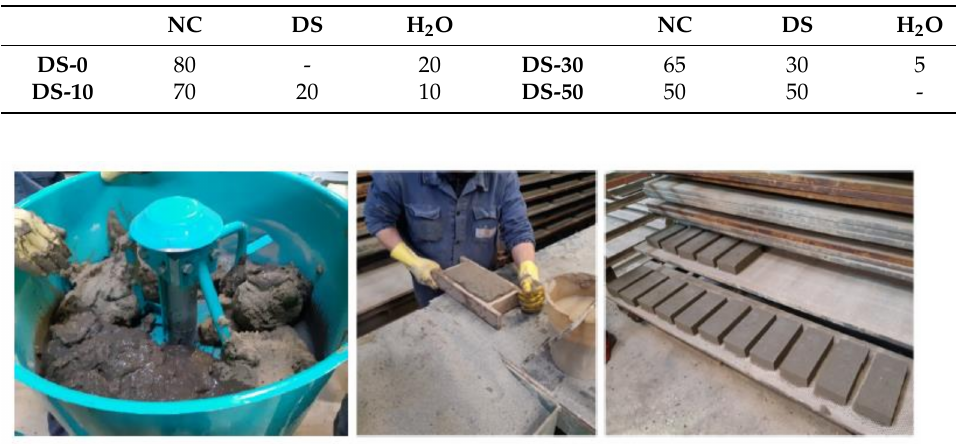
Figure 1. Main steps of brick manufacturing, from the left, preparation of DS and NC mixture, molding, and curing